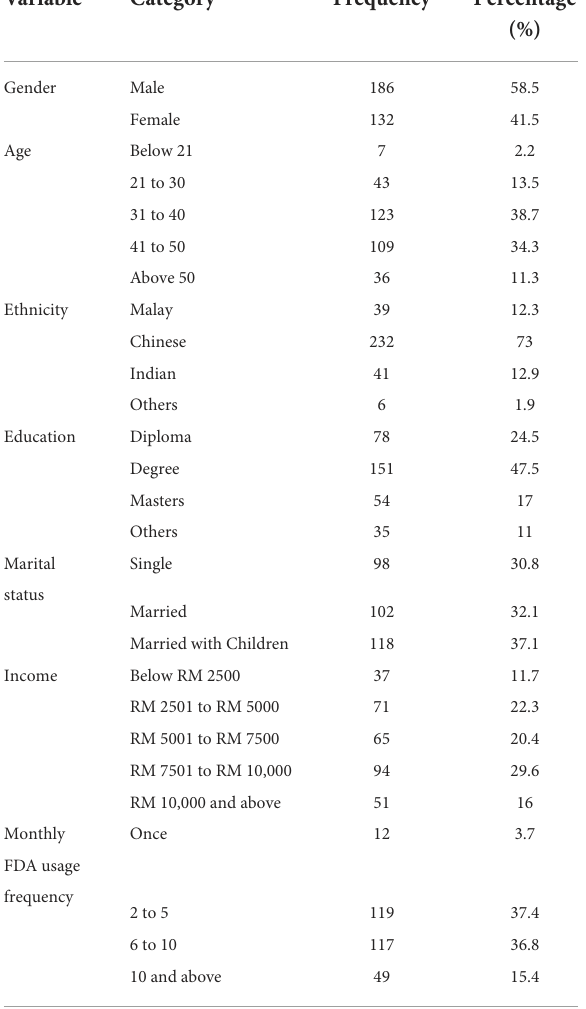
TABLE 1 Demographics of participants ( N =